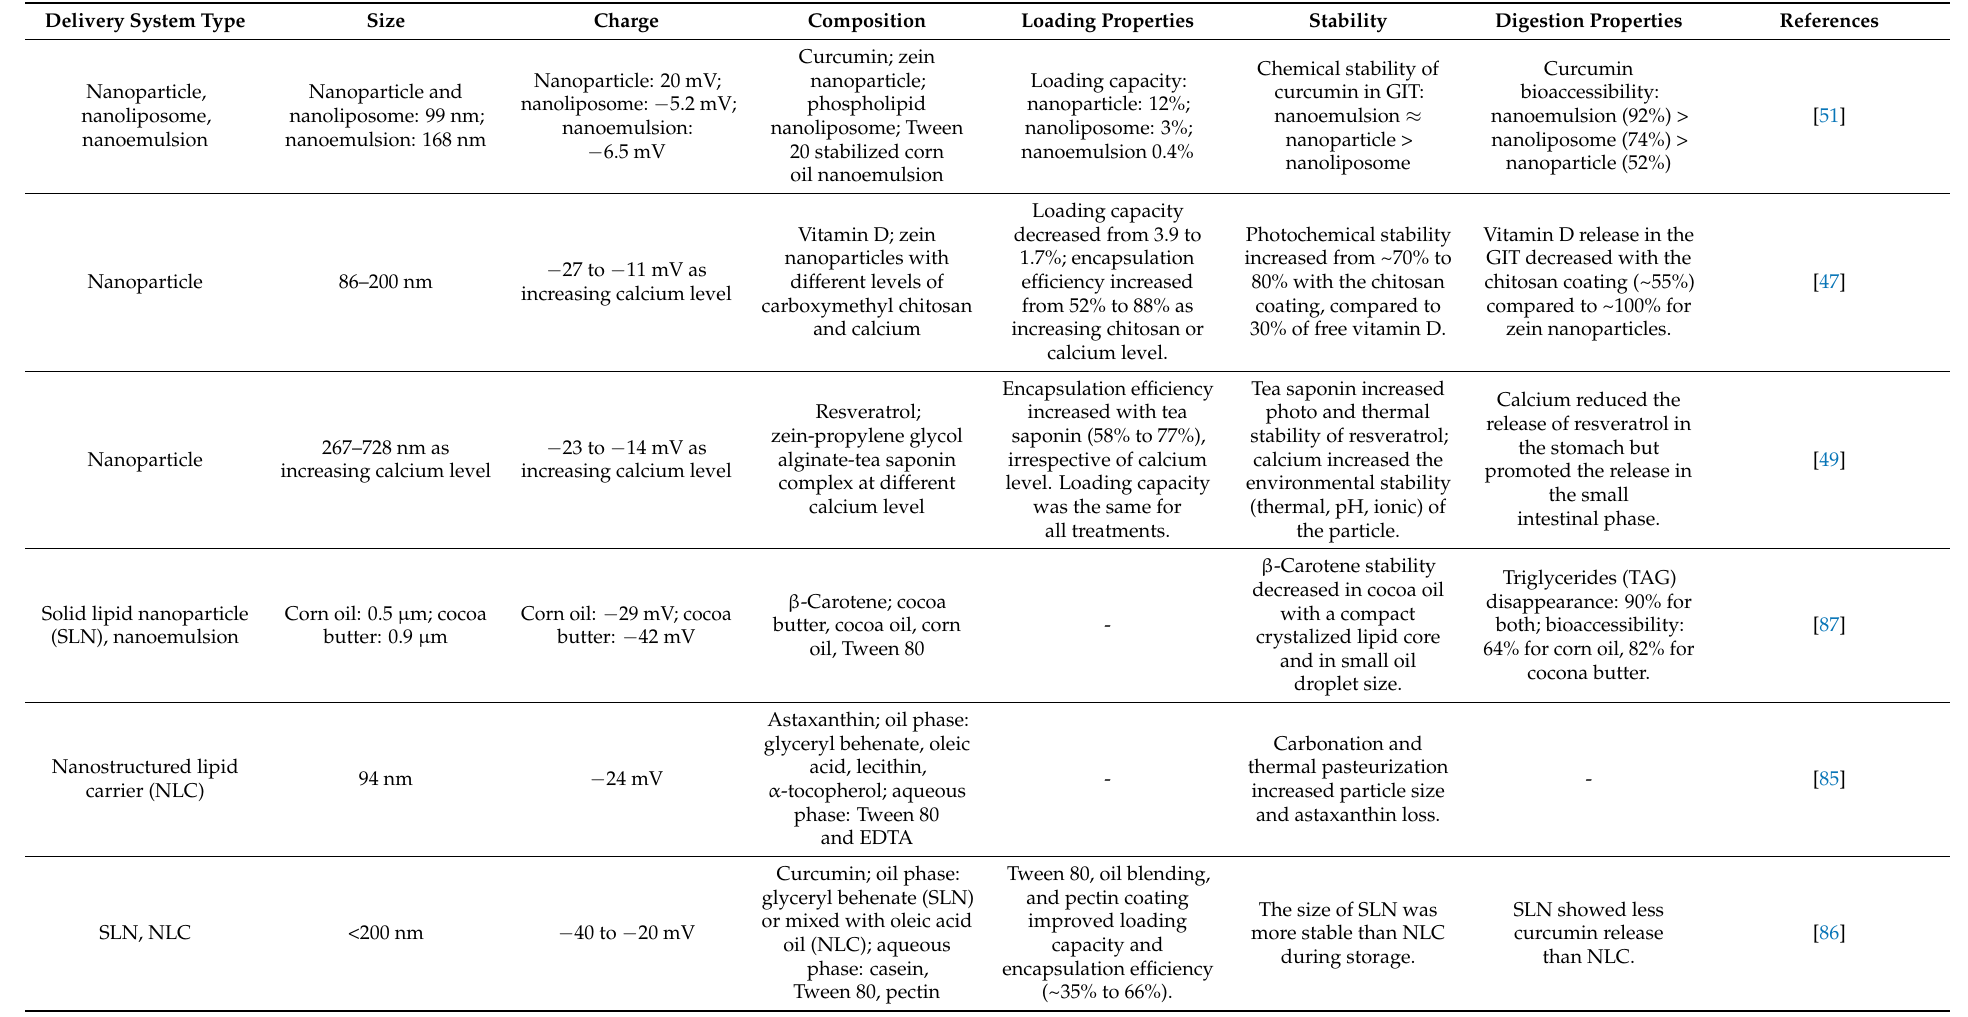
Table 1. Encapsulation properties, stability, and gastrointestinal fate of different types of delivery systems for hydrophobic